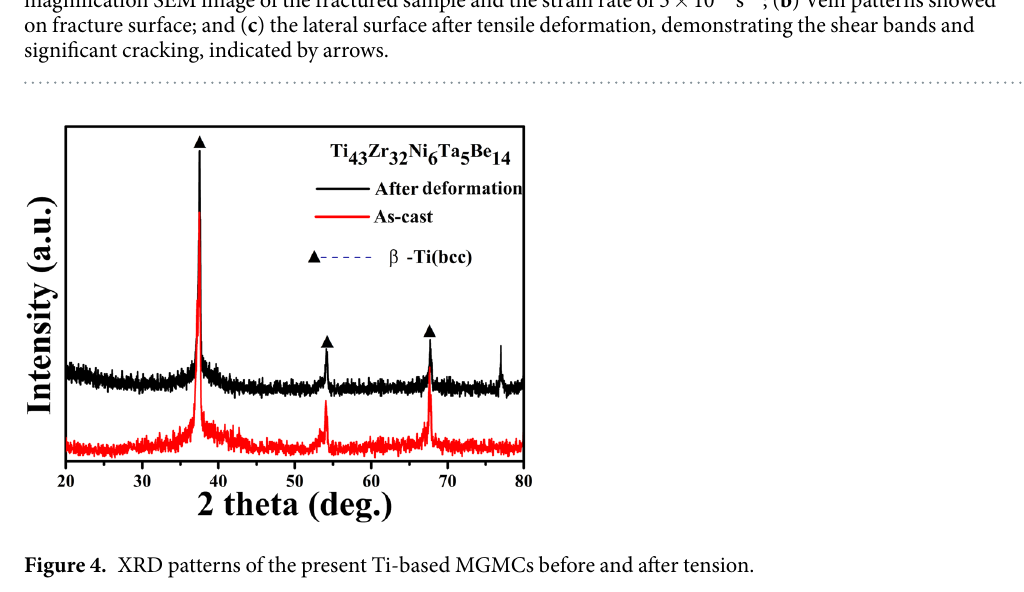
Fig. 5(e) is taken from the part of rectangle A in Fig. 5(d), from which the feature of the deformation twins is clearly visualized, as denoted by the red line, and visible dislocations at the grain boundary of the twinning can be found. Figure 5(f) shows the IFFT image corresponding to the part of rectangle B, the deformation twinning at the twinning boundary is displayed, as denoted by the red line. And stacking faults can be observed at the twin- ning boundary, as shown in the part of dash rectangle in Fig. 5(f). Twinning is a fundamental deformation mode that competes against dislocation slip in crystalline alloys. Generally, higher stress is thought to favor twinning over the dislocation slip, and deformation twinning has been well documented in fcc and hexagonal-close packed (hcp) alloys 20 . Scarcely, twinning is essentially found in nano- and micro-scaled bcc crystalline alloys such as Ta 21 , W 22 , Mo 23 , and V crystals 24 . Previously, in in-situ MGMCs, the dendrite phase is mainly composed of Zr-Ti-Nb